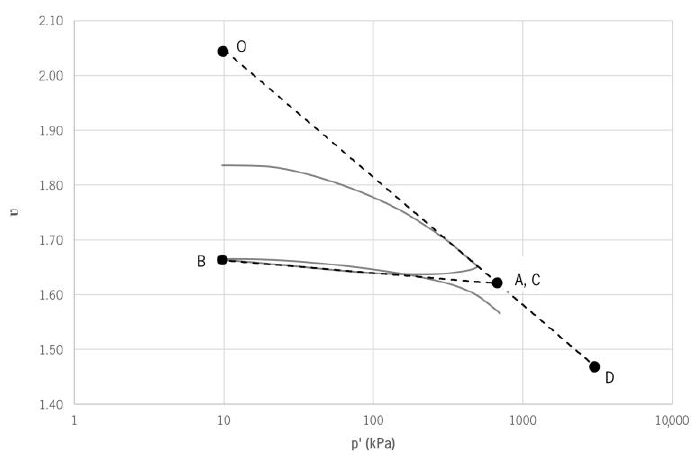
Figure 9. Isotropic compression and expansion curve.